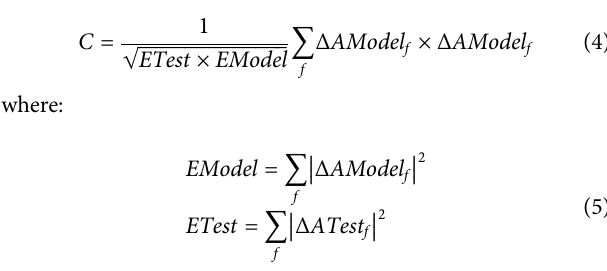
Frontiers in Mechanical Engineering |